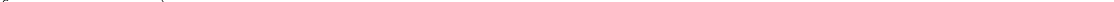
figure on next Fig. 2 Cell viability, ROS and gene evaluation. Cytotoxic effect of PET‑NPs on RAW 264.7 cells after incubation with ( A ) 0.0001 to 10 mg/mL or ( B ) 7.5, 15, 30, and 60 µg/mL of nanoparticles for 24, 48, and 72 h. DMSO was set up as a positive control for the viability assays ( n 3). Additionally, = PET‑NPs by themselves have not shown fluorescence at 24, 48, 72 h of incubation. C ROS production test of the macrophages exposed to PET‑NPs. TBHP was set up as a positive control for the ROS production assays ( n 3). All data were expressed as the mean SD. All differences were = ± identified via one‑way ANOVA, followed by Tukey’s multiple comparison test. * represented the significantly different ( p < 0.05, p < 0.01, p < 0.001, and p < 0.0001) as compared with the control. D Upregulated genes (log2 > 2) from macrophages incubated in presence of PET‑NPs. E Plot of cell number vs fluorescence (resazurin reduction). Results showed no significant differences between control and PET‑NPs at 24 h. However, an increment in fluorescence is observed at 48 and 72 h (15 and 30 μg/mL of PET‑NPs), but the cell amount from the same time showed a decrement in all samples incubated in presence of PET‑NPs and compared to